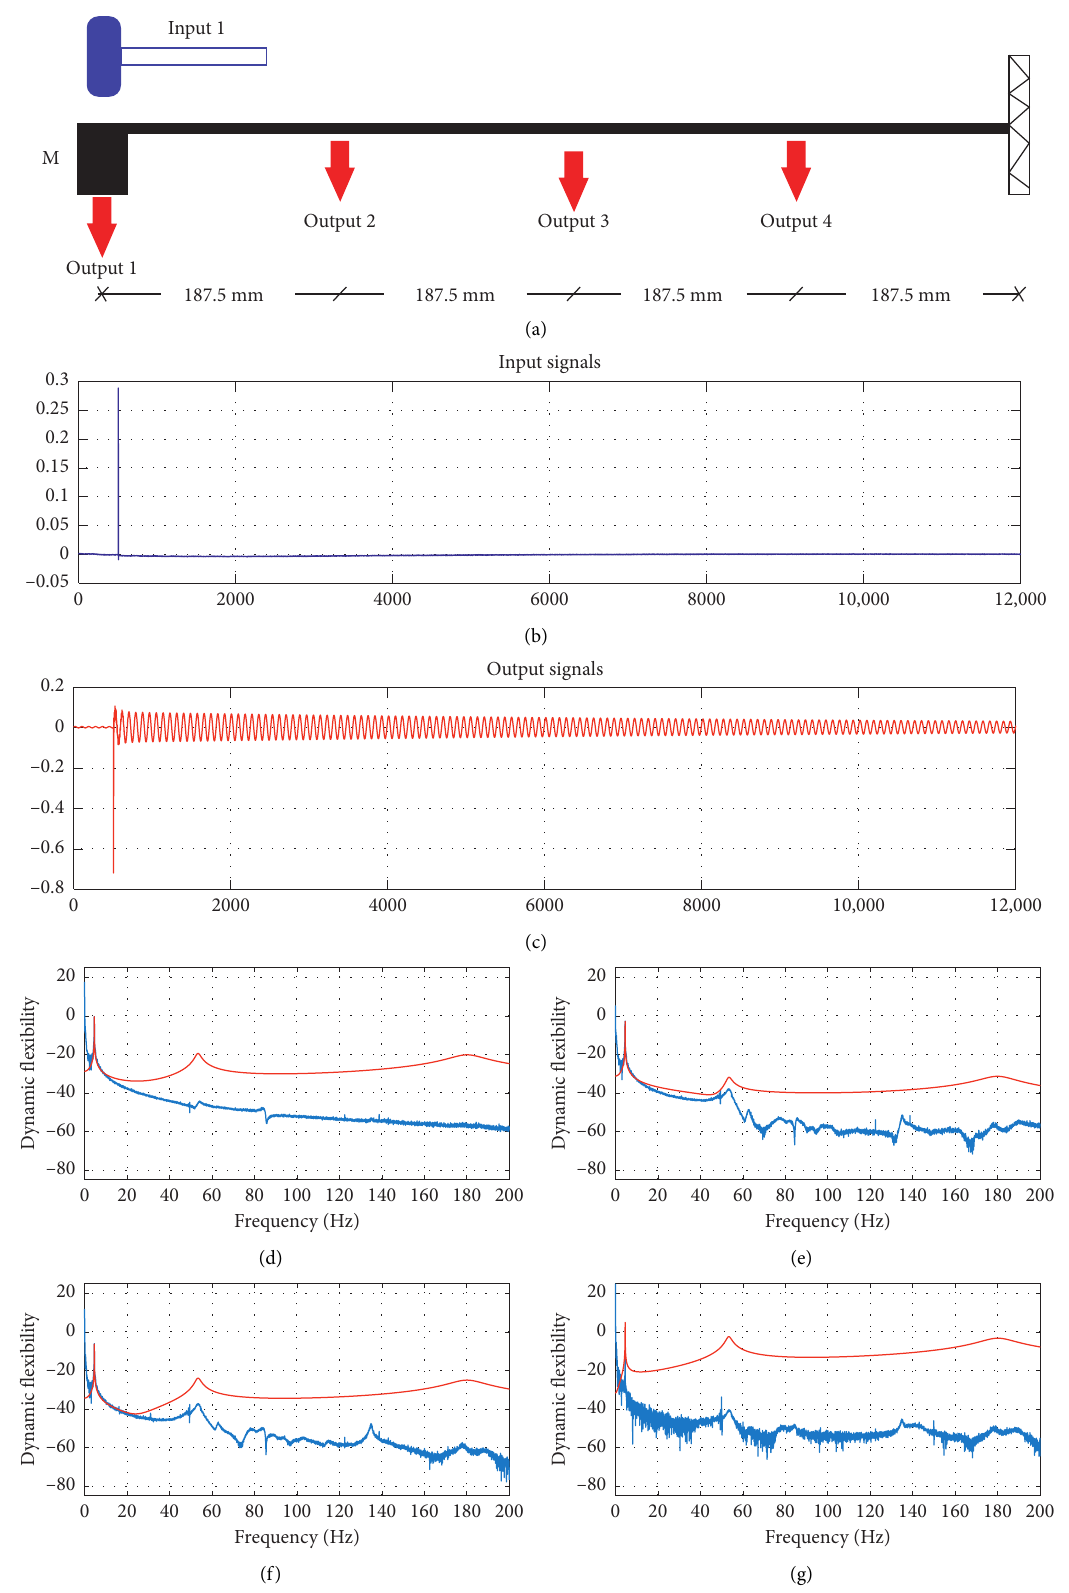
Figure 4: The frequency response functions (FRFs) for experimental tests in the studied beam. (a) Output 1, Input 1. (b) Output 2, Input 1. (c) Output 3, Input 1. (d) Output 4, Input